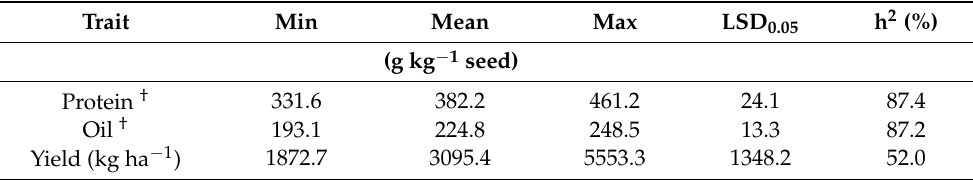
Table 2. Descriptive statistics of protein and oil (g kg − 1 seed) and yield (kg ha − 1 ) of soybean seed from 302 F 5:11 -derived recombinant inbred lines of Essex 86-15-1 × Williams 82-11-43-1 grown in 2013 in Knoxville, TN; Springfield, TN; and Milan, TN.